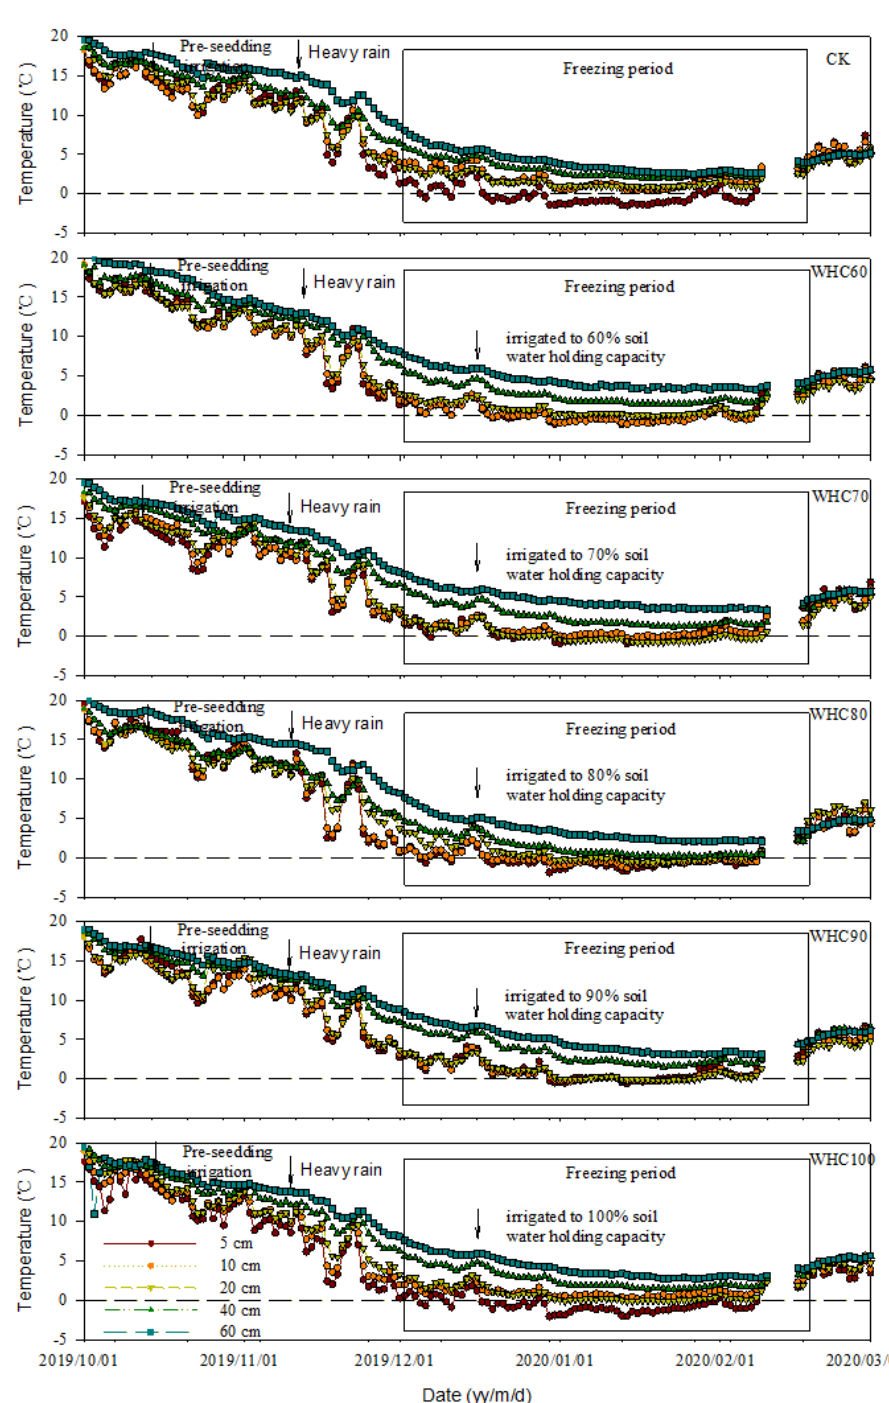
Figure 3. Soil temperature at 5, 10, 20, 40 and 60 cm depths from different treatments. Arrows indicate the occurrences of pre-seeding irrigation (17 October 2019), heavy rain (8 November 2019) and winter irrigation (15 December 2019). CK refers to the treatment without winter irrigation. WHC60, WHC70, WHC80, WHC90 and WHC100 refer to the treatments with winter irrigations where soil in 0–30 cm was irrigated to 60%, 70%, 80%, 90% and 100% of the soil water holding capacity on 15 December 2019,